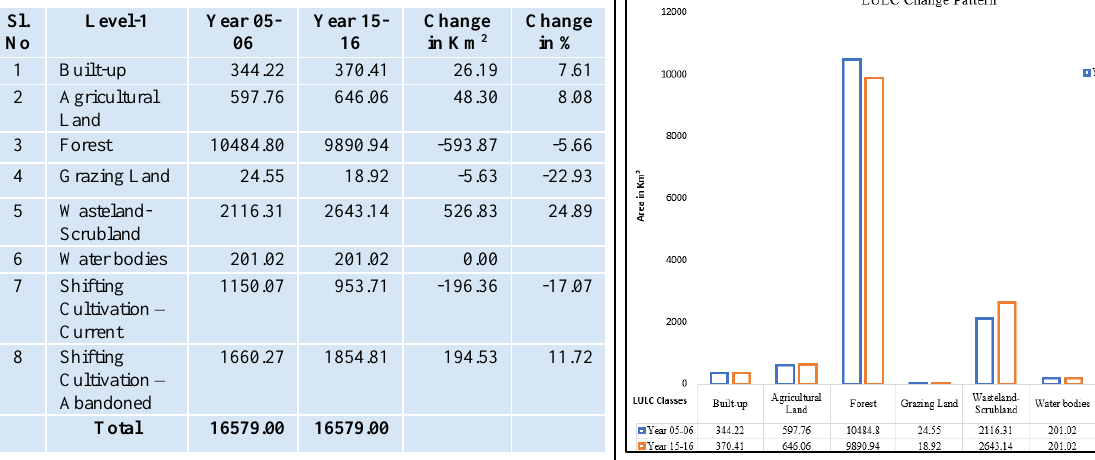
Figure 4: Bar plot showing the land use changing pattern for 10